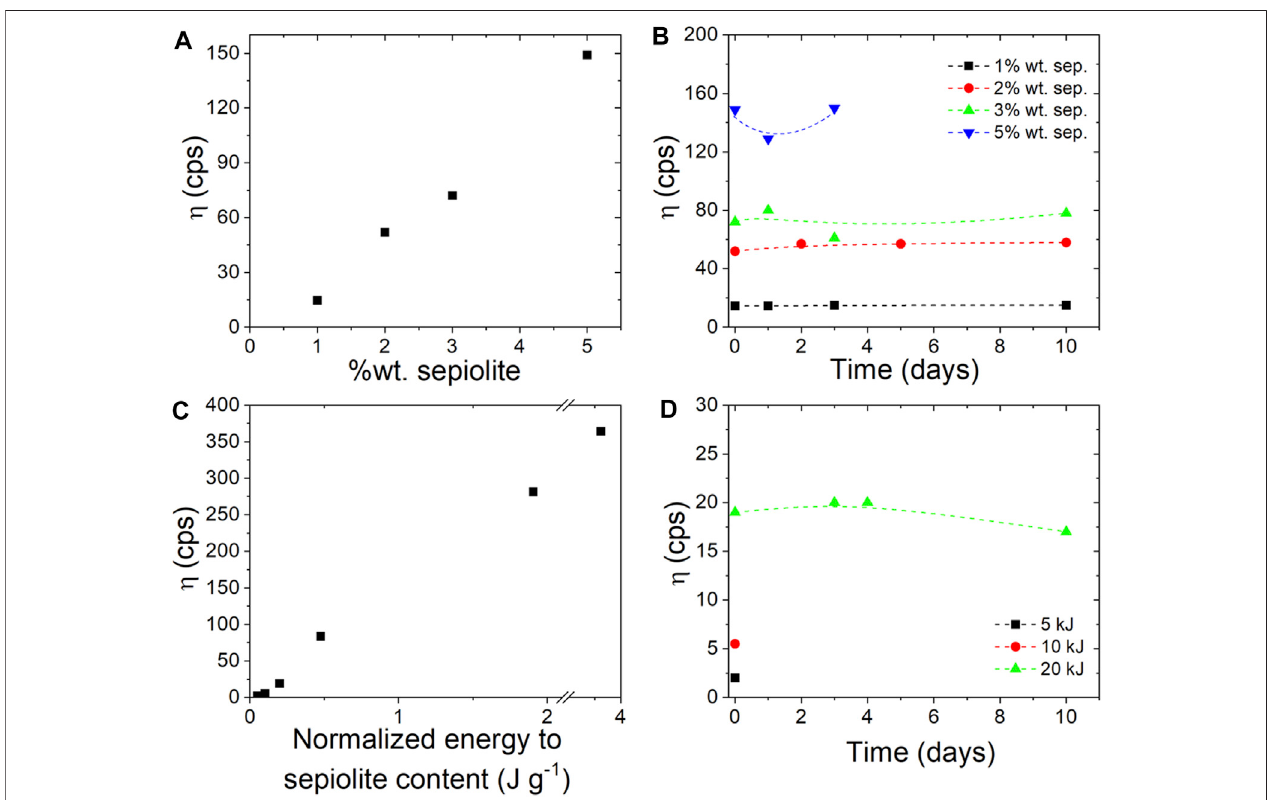
FIGURE 3 | Brook fi eld viscosity of hydrogels measured using RV5 at 100 rpm: (A) of hydrogels obtained with different sepiolite content and applying the same energy value (20 kJ), (B) at different times of the hydrogels prepared using 1, 2, 3 and 5 wt% of sepiolite content and applying 20 kJ of energy, (C) after the sonomechanical irradiation of sepiolite clay at different energies, and (D) of hydrogels obtained from dispersion of 1 wt% sepiolite and applying 5, 10 and 20 kJ of sonomechanical energy.